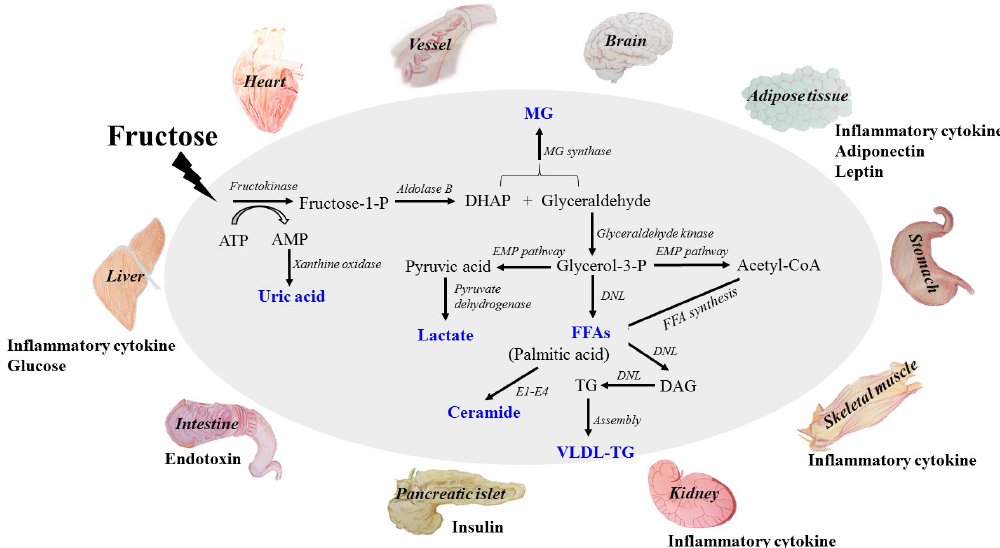
Figure 1. The metabolites of fructose catabolism and the adverse effects of high fructose consumption on tissue and organ functions in a direct and/or indirect manner. Fructose is mainly metabolized in liver to produce glucose, lactate, triglyceride, free fatty acid, uric acid and methylglyoxal. High levels of these metabolites are the direct dangerous factors. These dangerous factors impair the functions of local tissues and organs to overproduce inflammatory cytokine, adiponectin, leptin and endotoxin, which act as indirect dangerous factors. Meanwhile, glucose, insulin and ghrelin contents in system circulation are also disturbed. Fructose and its metabolites directly and/or indirectly cause oxidative stress, chronic inflammation, endothelial dysfunction, autophagy and increased intestinal permeability, and then further aggravate metabolic syndrome with tissue and organ dysfunctions. DHAP, dihydroxyacetone phosphate; TG: triglyceride; FFA: free fatty acid; UA: uric acid; MG: methylglyoxal;